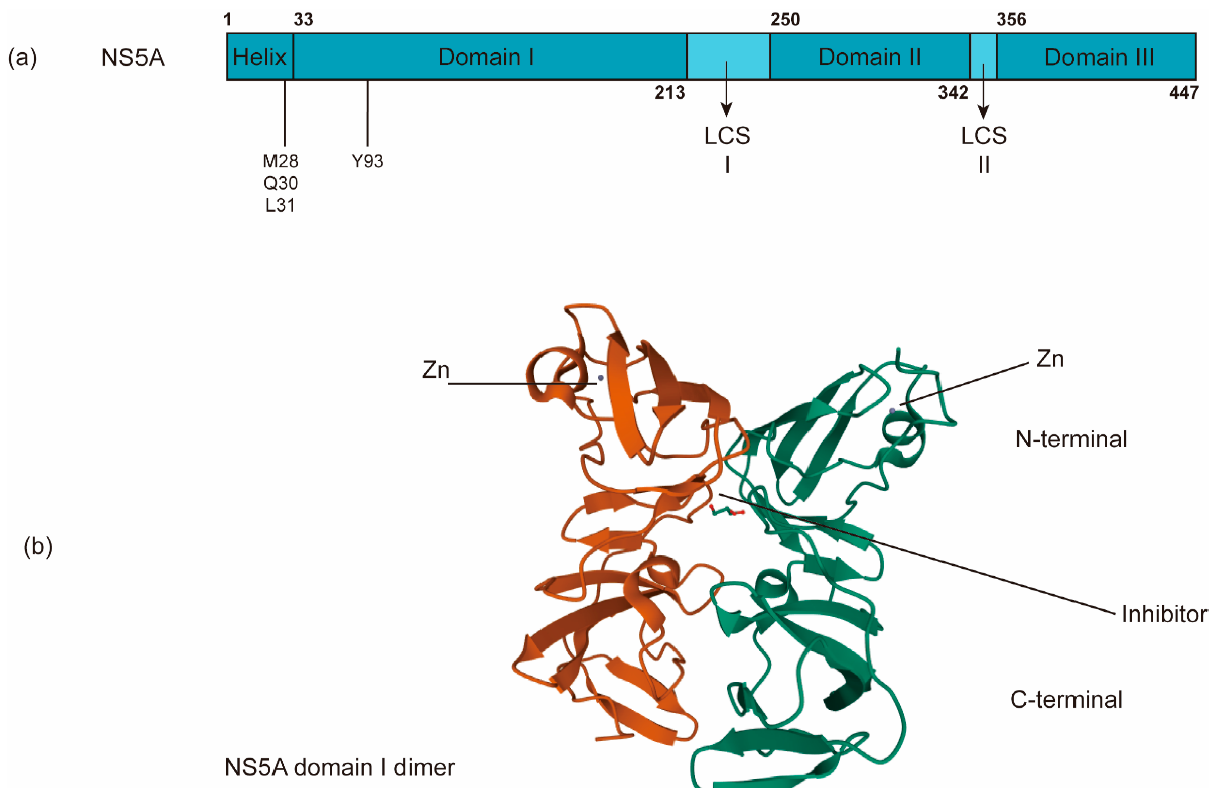
Figure 5. The schematic organization of NS5A domains. ( a ) NS5A contains an N-terminal amphipathic α -helix critical for its targeting of the membrane and three domains (domains I, II and III) separated by two low-complexity sequences (LCS). ( b ) NS5A inhibitors bind the dimerized domain I, thereby potentially blocking NS5A to exert its functions (PDB: 3FQQ). RAVs of NS5A inhibitors are often in M28, Q30, L31, and Y93.